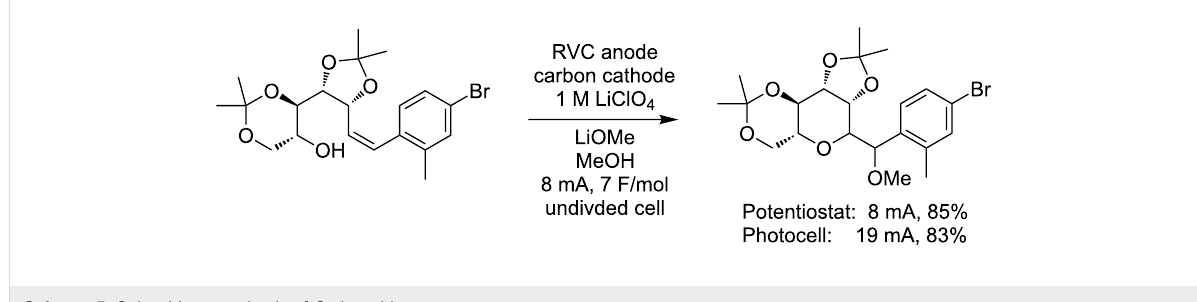
Scheme 5: Solar-driven synthesis of C -glycosides.